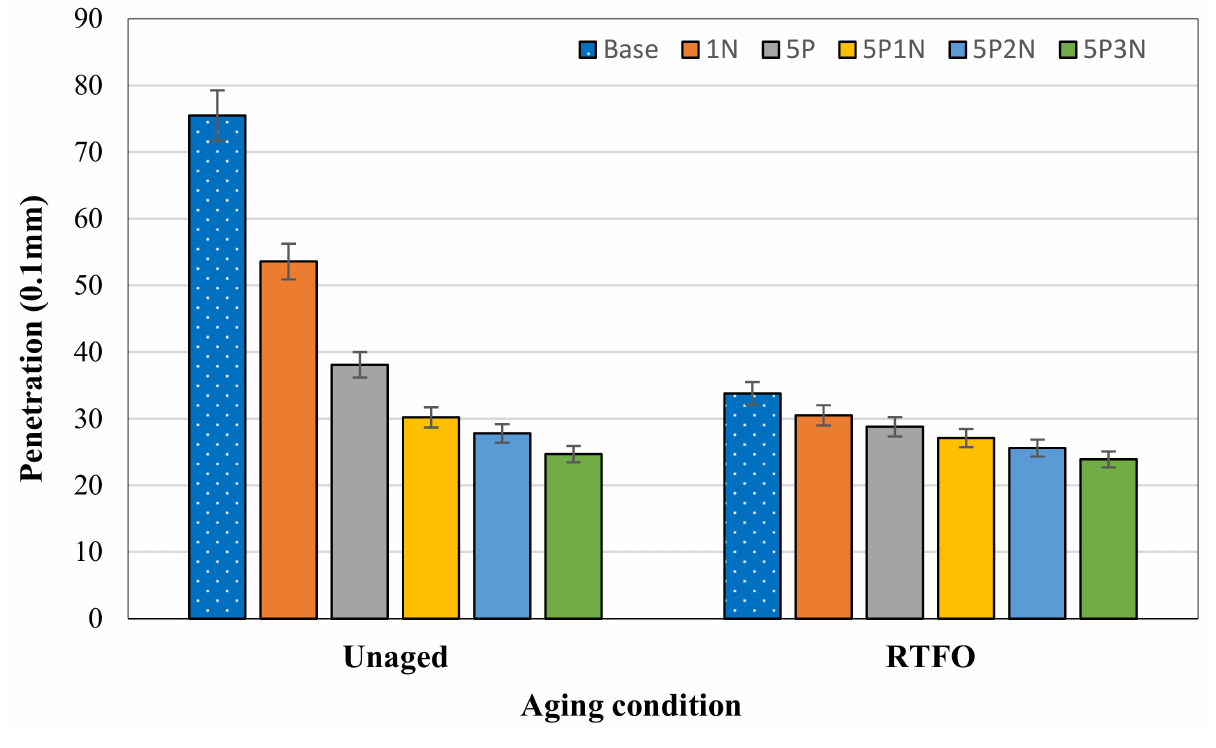
Figure 3. Penetration of AH-70 asphalt modified with PVC and NS.